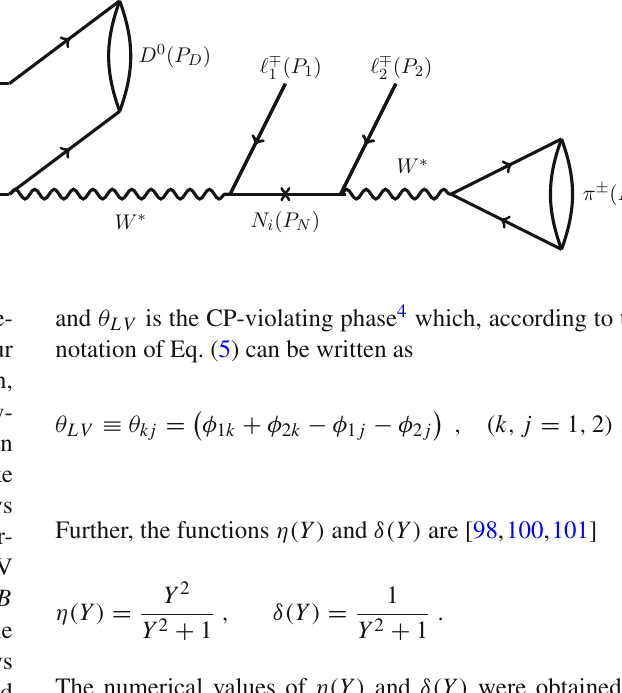
Fig. 1 Feynmann diagram of the decay